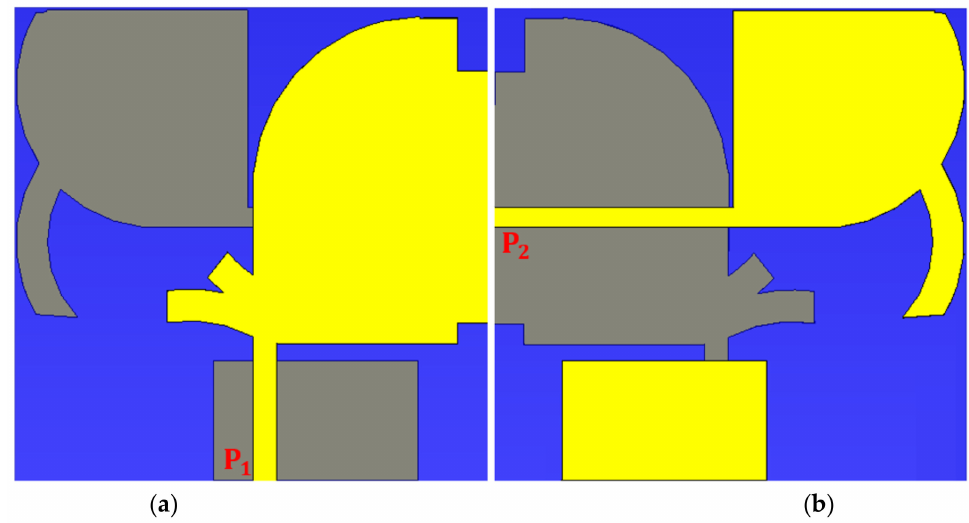
Figure 6. The antenna prototype after combination ( a ) front and ( b ) back views. Ant 1 and Ant 2 modes of operation give vertical and horizontal polarizations, respec- tively. W f and W f1 are taken into account to match the width of the feed lines. L f and L f1 also have an impact on the matching. We included SMA connections in the simulations to account for the influence of the connectors (two different ports used here (only normal SMA which covers till 18 GHz is shown). After we measured the antenna and were sure that the results agreed, the ports changed to the new one taken from the following port. [60]). High isolation is expected because two radiation modes (Ant 1 and Ant 2) are both horizontally and vertically polarized. The simulated S 11 and S 21 results of the combined antennas are presented in Figure 7. The high level of isolation is evident since the S 21 value is less than − 18 dB. In addition, a perfect impedance matching was also obtained when reflection coefficients ≤− 10 dB. The antenna demonstrates the matching at most of the band for both antennas’ operational modes.